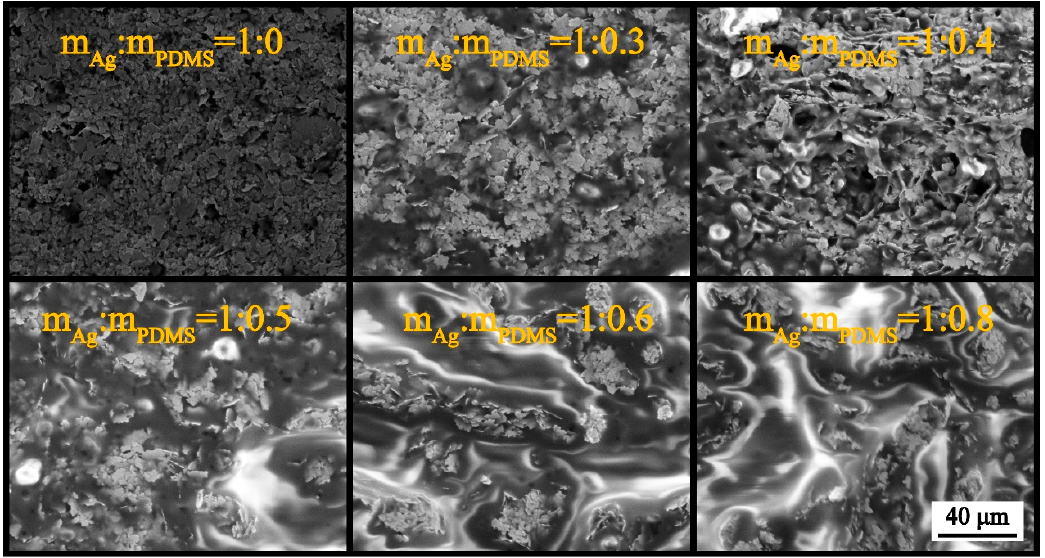
Figure 2. Morphology characterization of the stretchable electrodes based on PDMS-Ag nanosheets with different mass ratios.